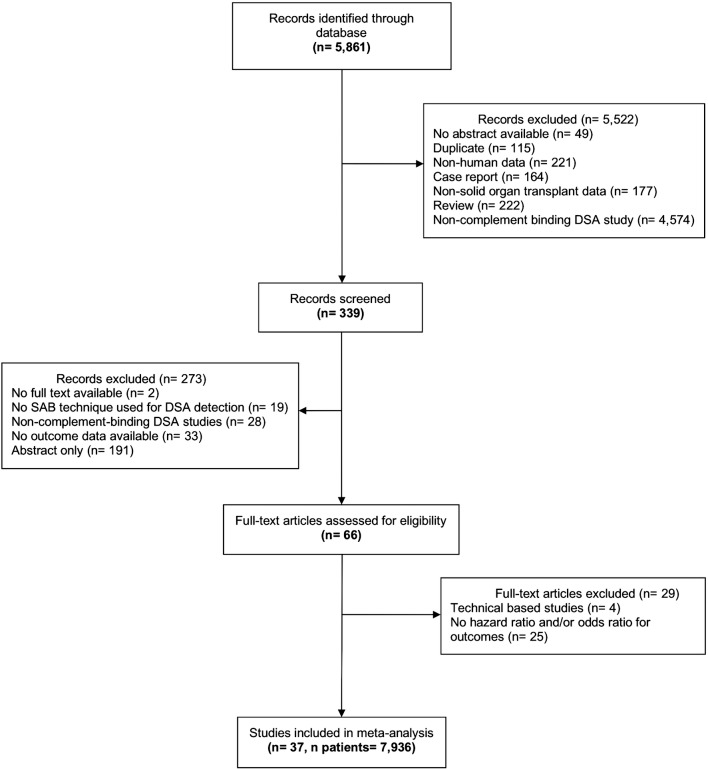
Flow chart summarizing the research strategy for study identification and selection.DSA, donor-specific antibody; SAB, single-antigen bead.